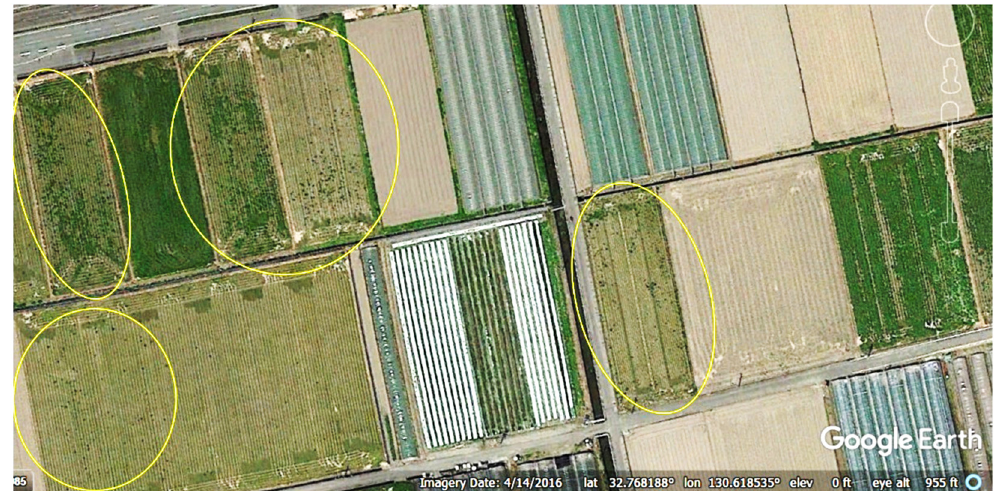
Figure 6. Example satellite imagery showing the small black circles and darkened areas that were originally thought by many researchers to possibly be sand boils and water from liquefaction but were later identified to be bundled and burned rice stalks.